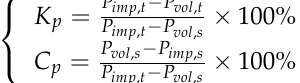
Figure 20. Airflow in the area near the volute tongue. 1.1